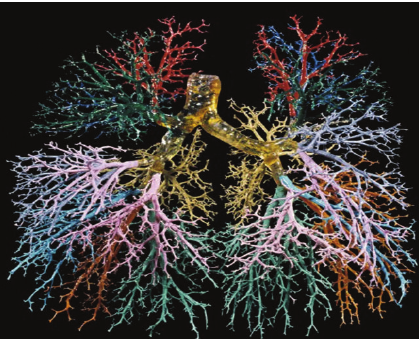
Figure 2: Multilevel branching structure of the human lung [11].